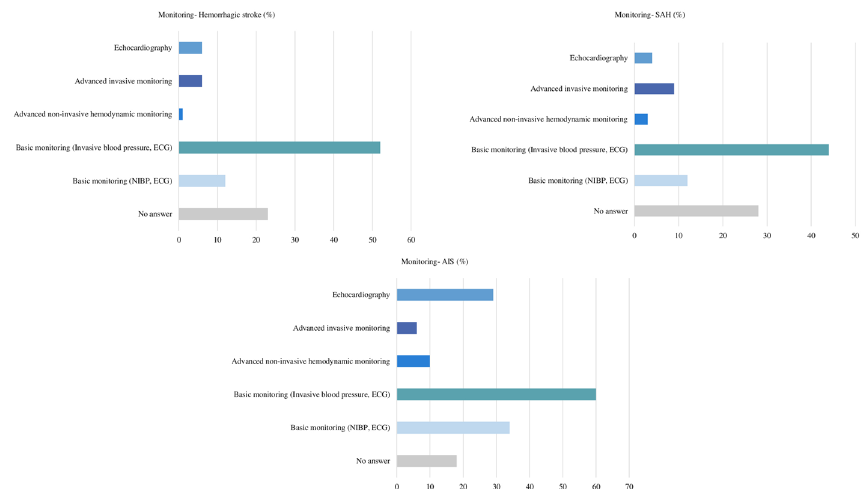
Fig. 2 Echocardiography, continuous hemodynamic monitoring and capillary refill time use in patients with subarachnoid hemorrhage (SAH) and acute ischemic injury (AIS). Data are expressed as percentage of the overall answers obtained by the